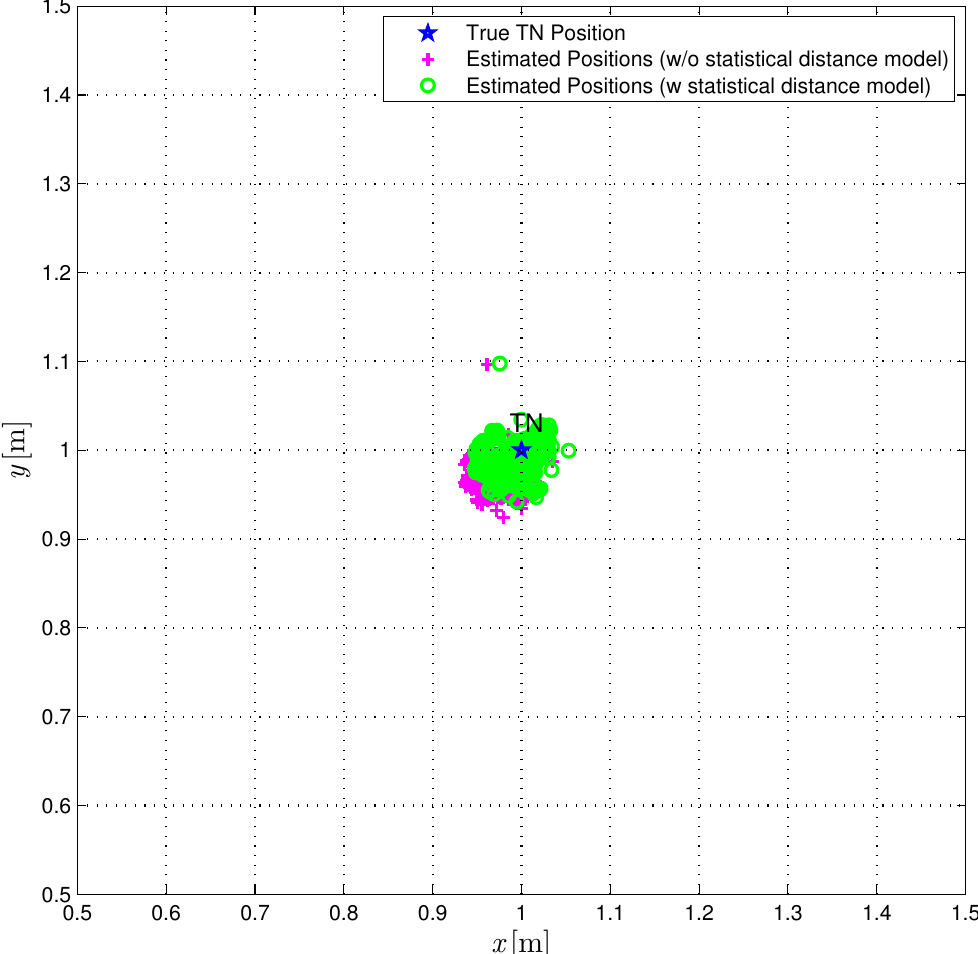
Figure 8. The 1000 position estimates obtained with the TSML localization algorithm are shown (magenta plus), together with the 1000 position estimates obtained when taking into account the statistical model for range estimates (green circles) and the TN (blue star).